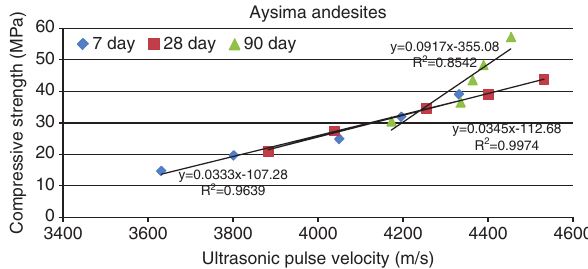
Figure 9 Relationship between ultrasonic pulse velocity and com- pressive strength of samples for Aysima